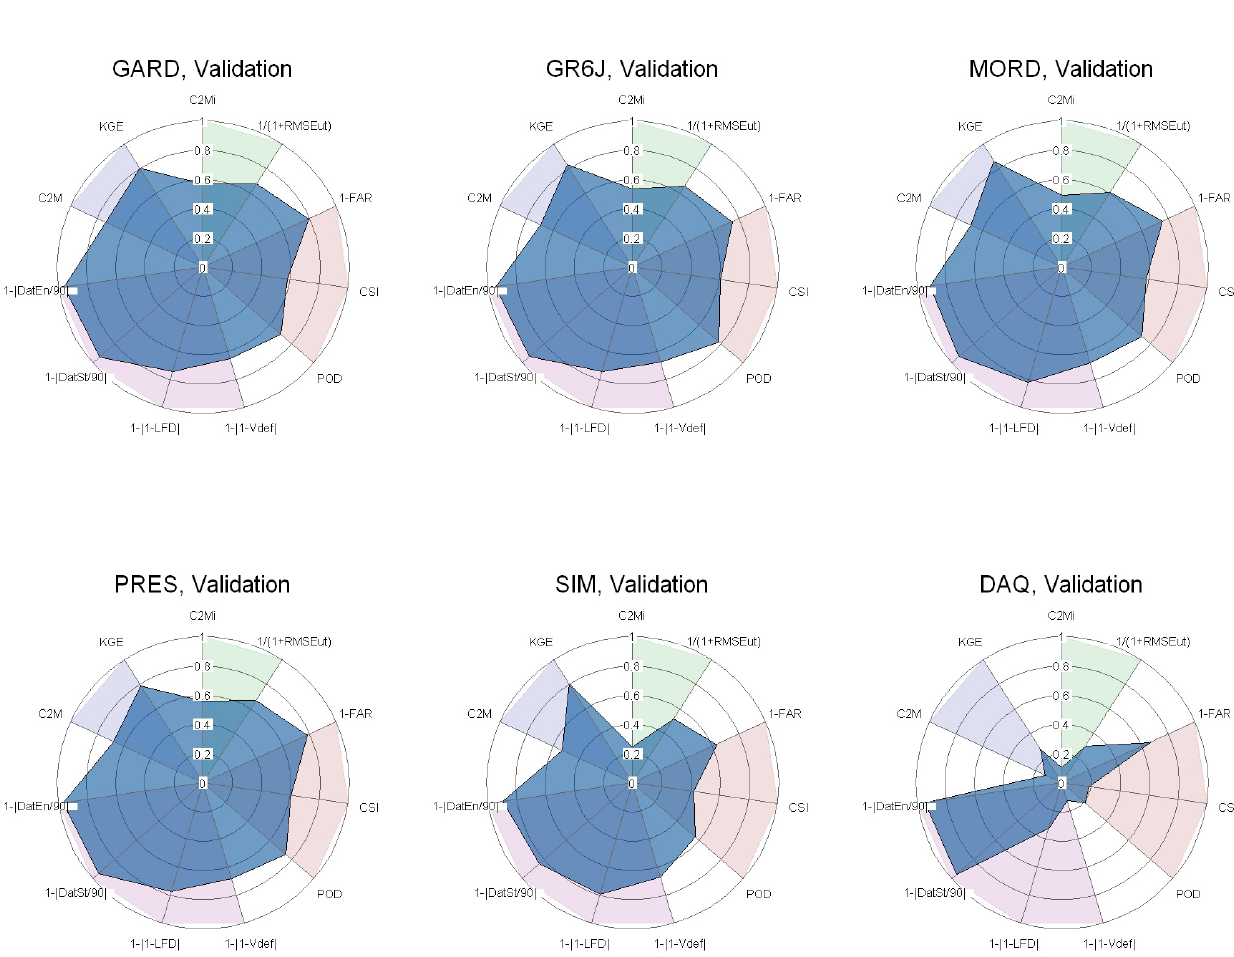
Figure 4. Radial plots showing the mean validation results obtained by the five tested models and the benchmark (DAQ) for the selected criteria over the 21 catchments and the two test periods, in simulation